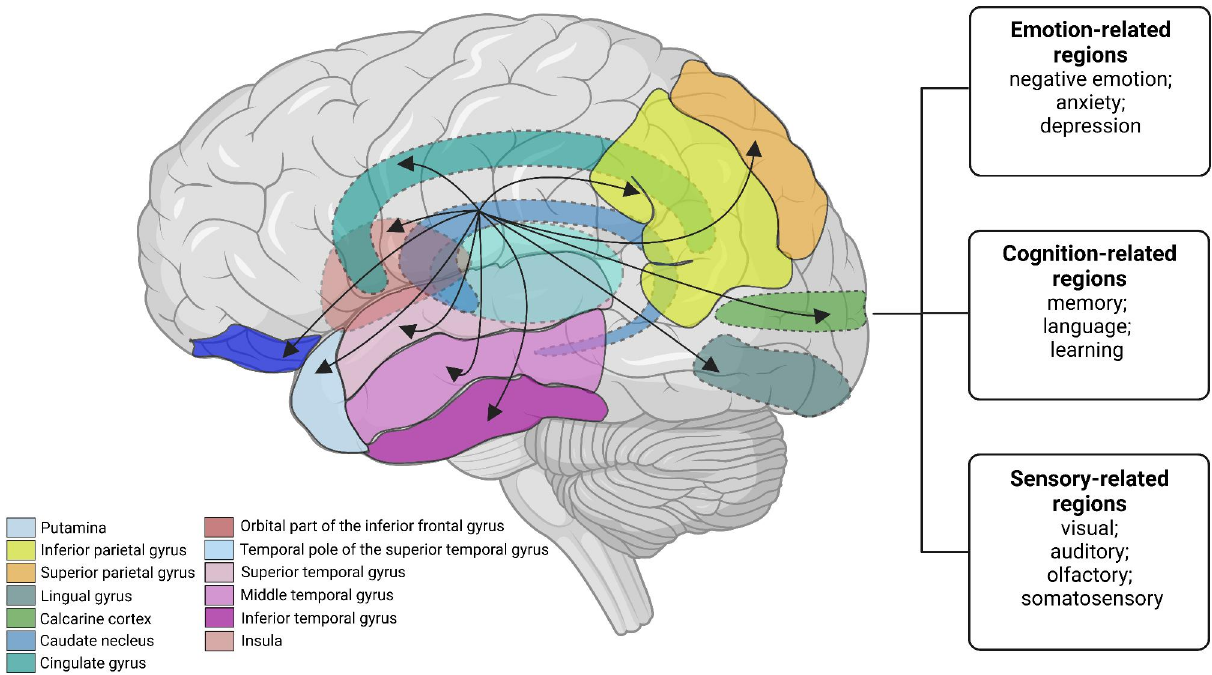
Fig. 5 Schematic diagram of the CM-related functional brain connectivity network. The diagram shows our results about the significantly en- hanced FC between the CN and brain regions associated with emotion, cognition, and sensory (the calcarine cortex, lingual gyrus, anterior cingulate cortex, superior and inferior parietal cortex, precuneus, temporal gyrus, insula, orbital part of the inferior frontal gyrus, and temporal pole of the superior temporal gyrus). The black arrows represent enhanced FC. The dotted line represents the tissue located inside the brain. Note: CM, chronic migraine; CN, caudate